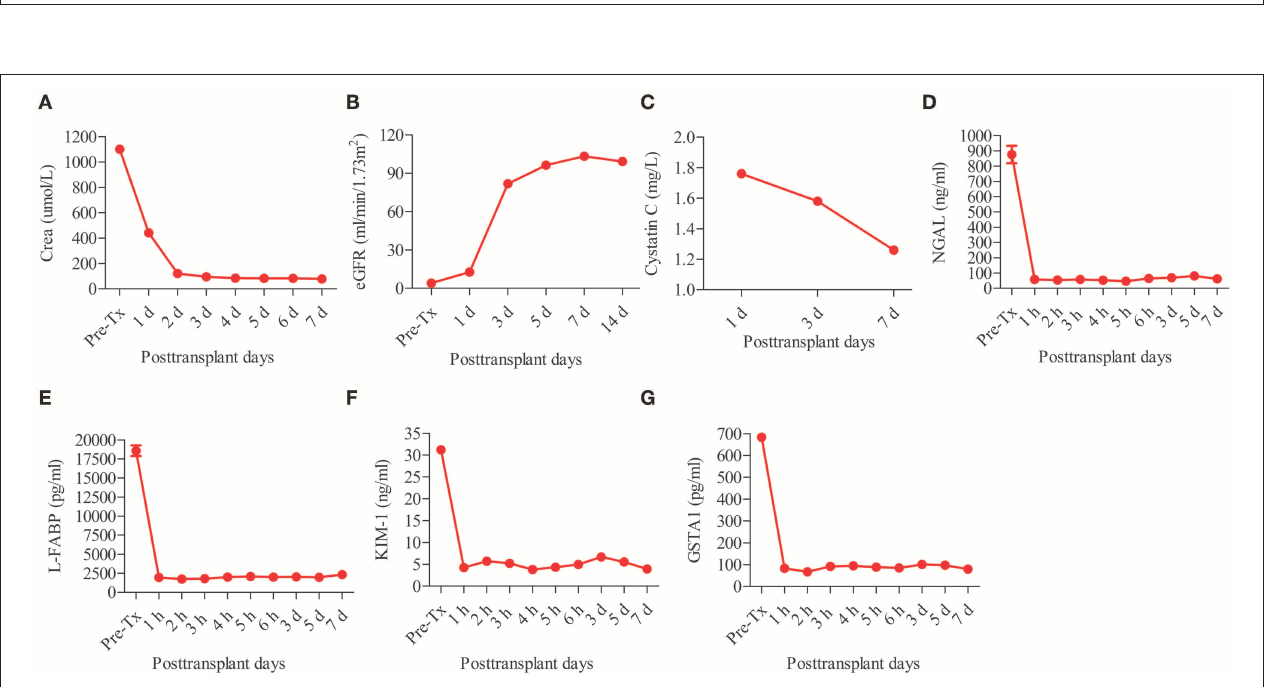
FIGURE 3 | Post-transplant renal function and serum biomarker levels of kidney injury of the recipient. The renal function tests including (A) creatinine (Crea) and (B) estimated glomerular filtration rate (eGFR). The serum biomarker levels of kidney injury including (C) cystatin C, (D) neutrophil gelatinase-associated lipocalin (NGAL), (E) liver fatty acid-binding protein (L-FABP), (F) kidney injury molecule-1 (KIM-1), and (G) glutathione s-transferase alpha 1 (GSTA1).